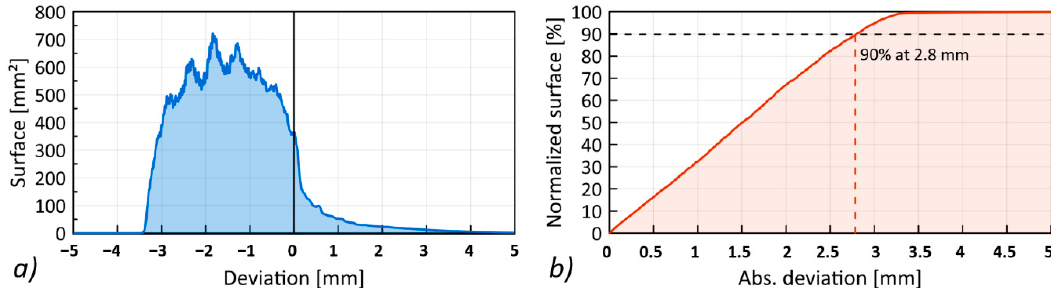
Figure 20. Quantitative evaluation of the differences in the simulation and experiment: ( a ) geometry deviation histogram, ( b ) cumulative deviation histogram.